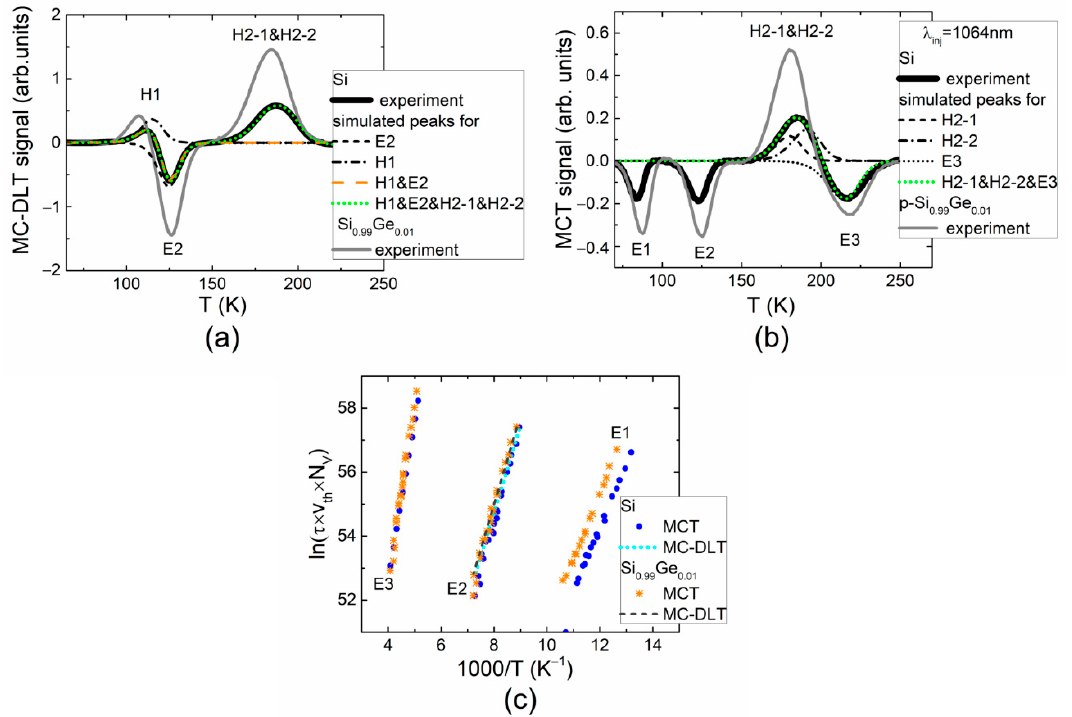
Figure 1. ( a ) The MC-DLTS spectra (solid curves) recorded under electrical carrier injection in 5.5 MeV electron-irradiated and boron-doped Si and Si 0.99 Ge 0.01 diodes (the dot curve represents the simulated spectrum, including all the traps inherent for the IR illuminated diode after prolonged (16 h) retention in dark (at 293 K temperature); ( b ) The MCT spectra (solid curves) of the same Si and Si 0.99 Ge 0.01 diodes recorded under optical injection implemented by short IR illumination of the diode edge and prolonged (16 h) retention in dark of the illuminated sample at 293 K temperature. Here, black curves represent spectra obtained for Si, while gray curves show these spectra recorded for Si 0.99 Ge 0.01 diodes, and the dotted curves illustrate the simulated spectral peaks. ( c ) Arrhenius graphs plotted for different peaks in MC-DLT and MCT spectra. Here, τ denotes carrier lifetime relative to emission; υ th is the carrier thermal velocity; N V is the effective density of free carrier states.